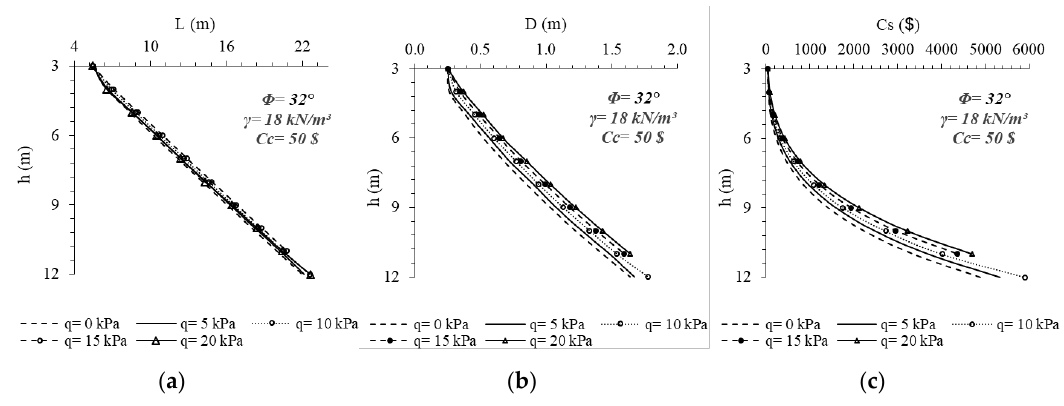
Figure 11. The effects of the change of external load to the diameter of the cantilever soldier pile ( a ), the length ( b ), and the unit cost of the pile ( c ) (for h = 6 m excavation depth) via the excavation depth.